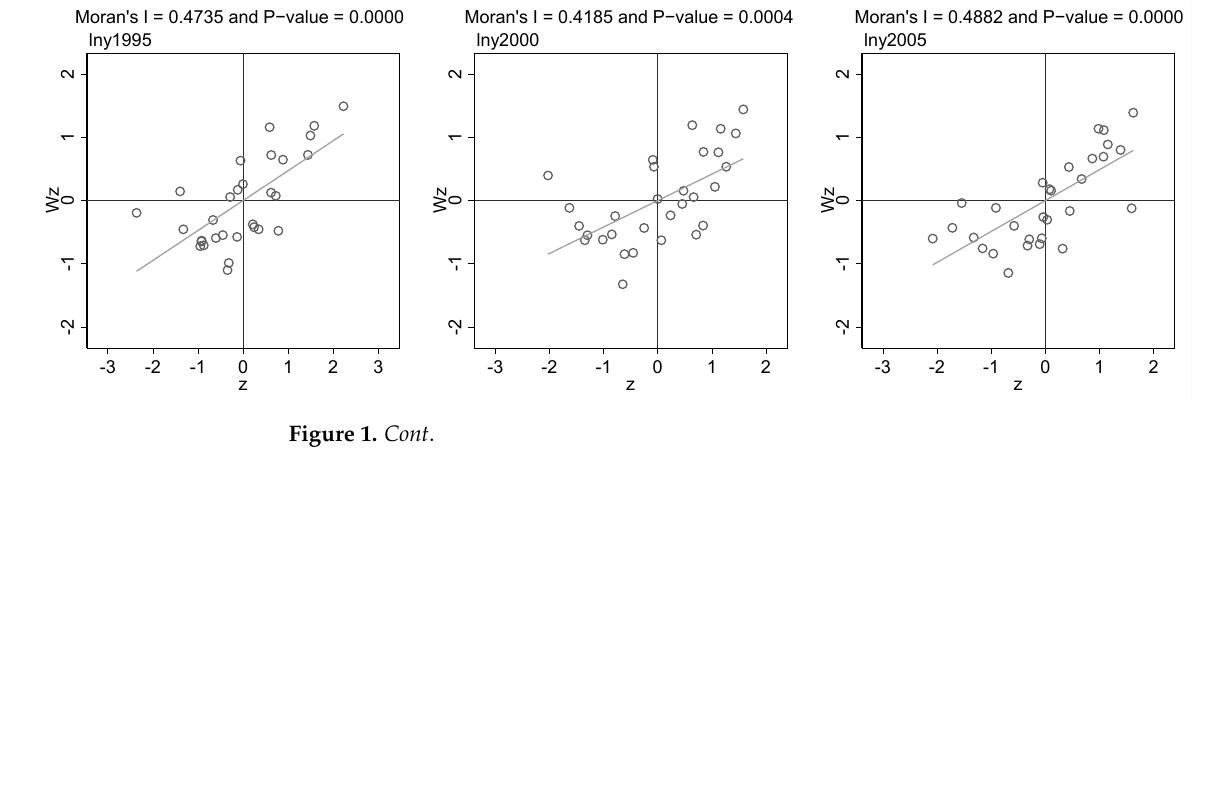
Figure 1. Moran scatter plot of provincial carbon productivity in